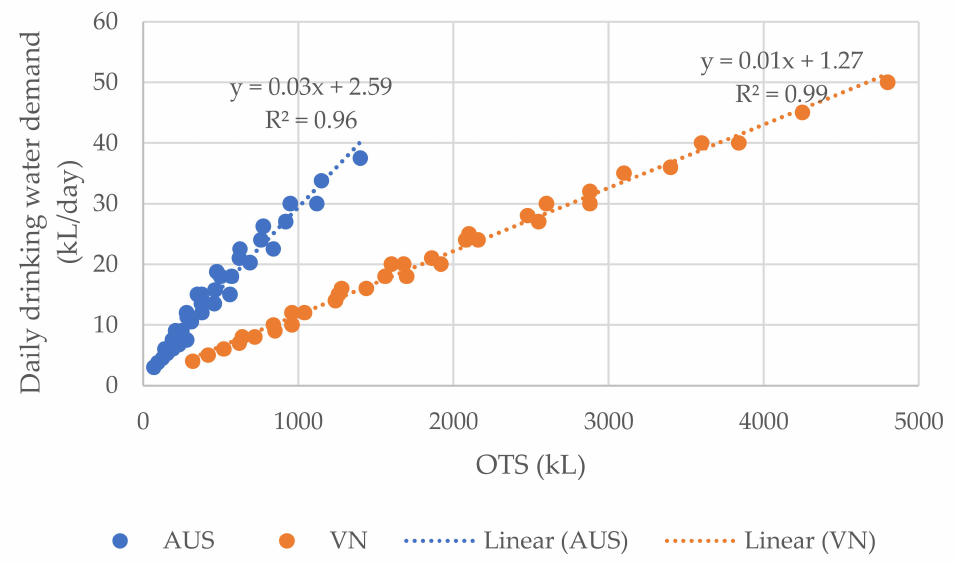
Figure 7. Correlation between daily drinking water demand and optimised tank size for the Aus- tralian and Vietnamese RWH